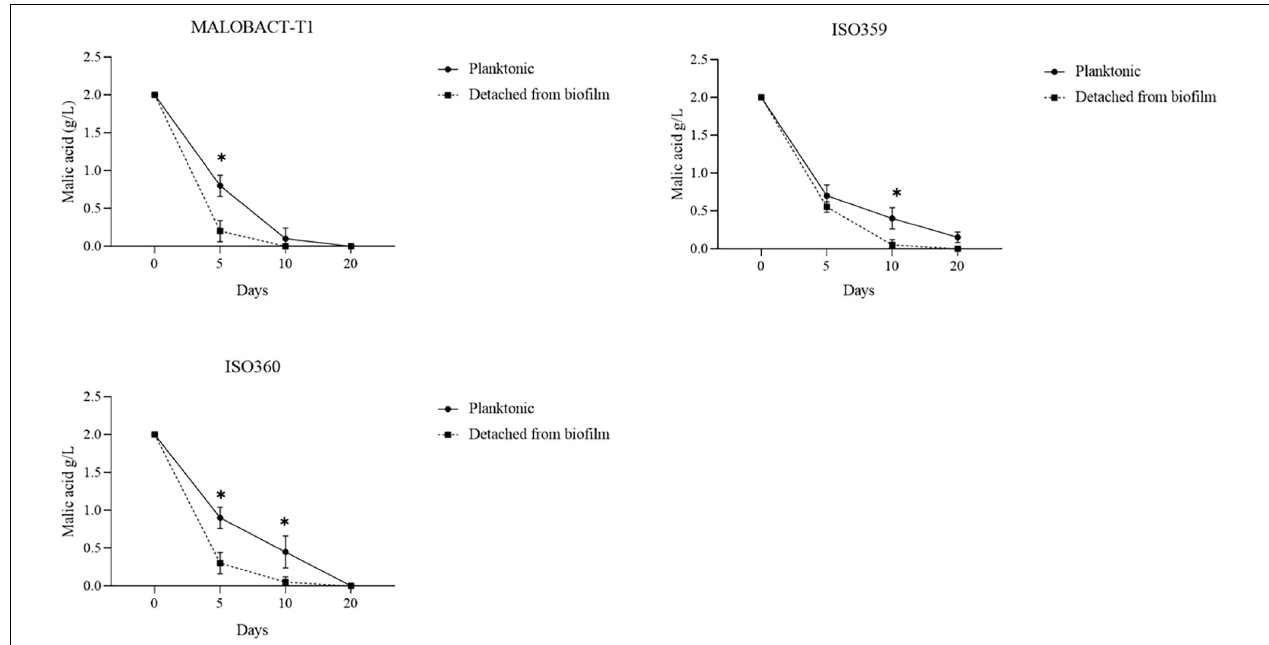
FIGURE 3 | Comparison of malic acid degradation by tested strains. Strains were inoculated as planktonic cells or after development as biofilm. Error bars represent the standard deviation of three biological replicates. The symbol ∗ denotes statistical differences ( p < 0.05).